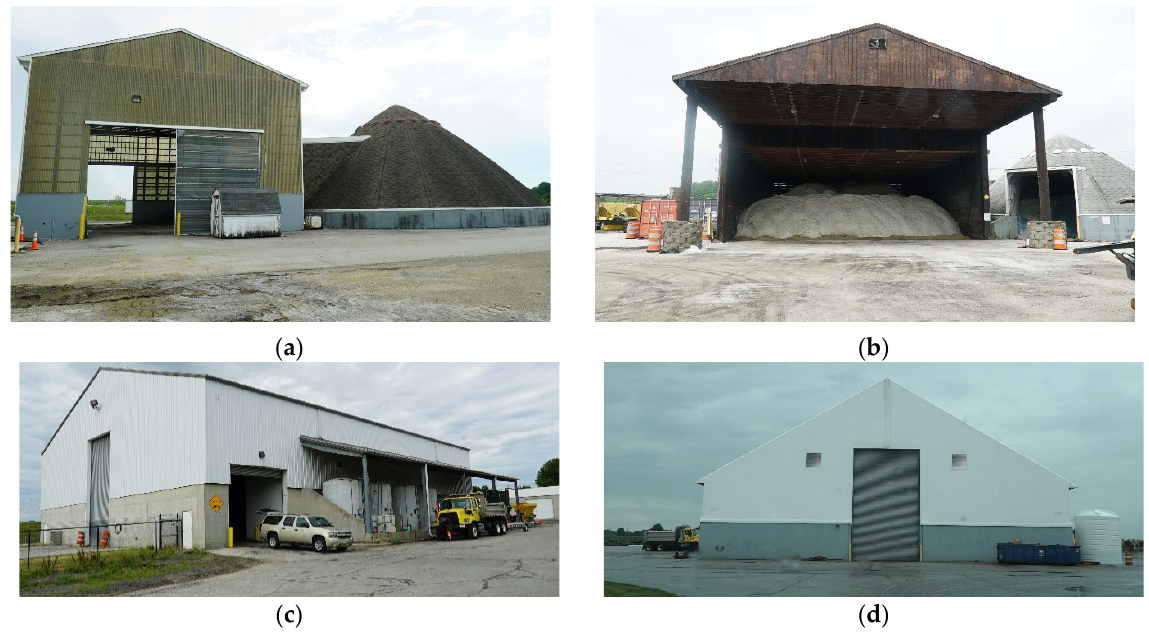
Figure 2. Examples of distinct INDOT salt storage facilities. ( a ) Sellersburg, Indiana Salt Facility ( b ) Bloomington, Indiana Salt Facility ( c ) Gary, Indiana Salt Facility ( d ) Rensselaer, Indiana Salt Facility.